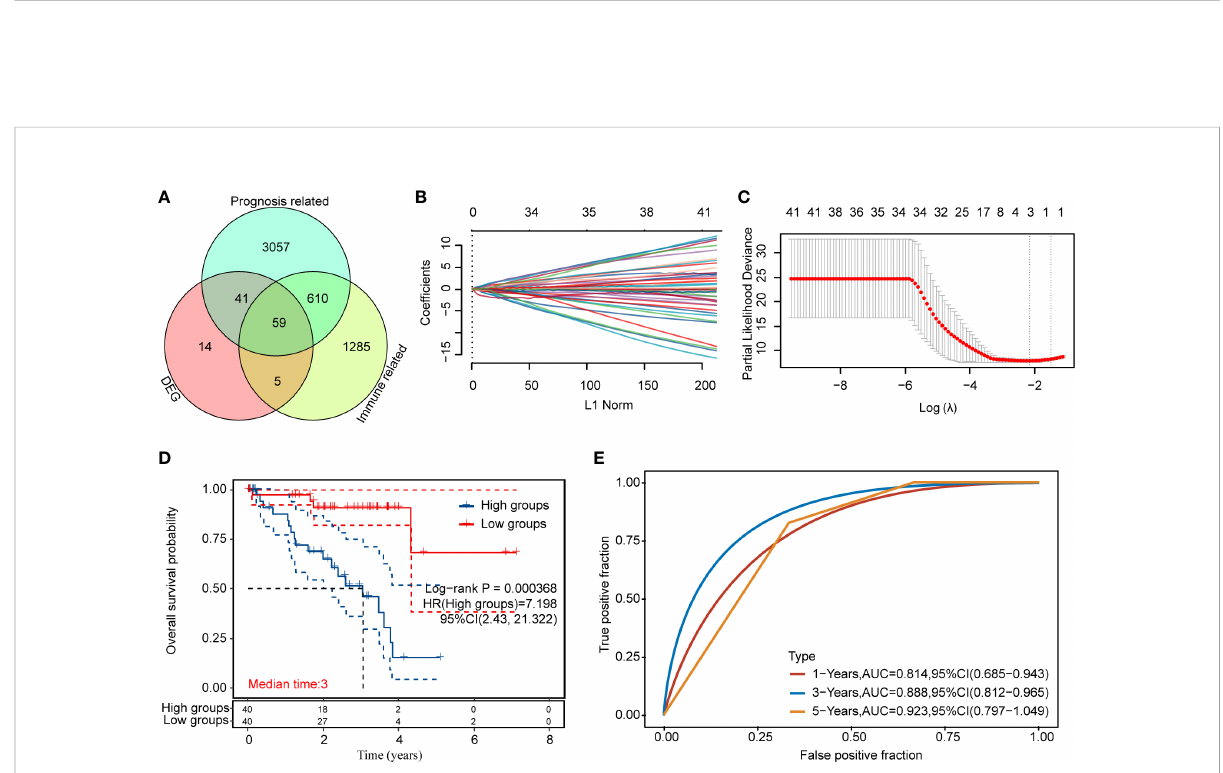
FIGURE 3 Immune-related prognosis model construction for DEGs (A) Intersection of the DEGs, prognosis-related genes, and immune-related genes; (B, C) distribution of LASSO coef fi cients of immune prognosis common genes of DEGs to obtain the adjustment parameter l .min = 0.000368; (D) KM survival curves for high- and low-risk groups; (E) ROC curves at 1, 3, and 5 years (statistically signi fi cant at p <